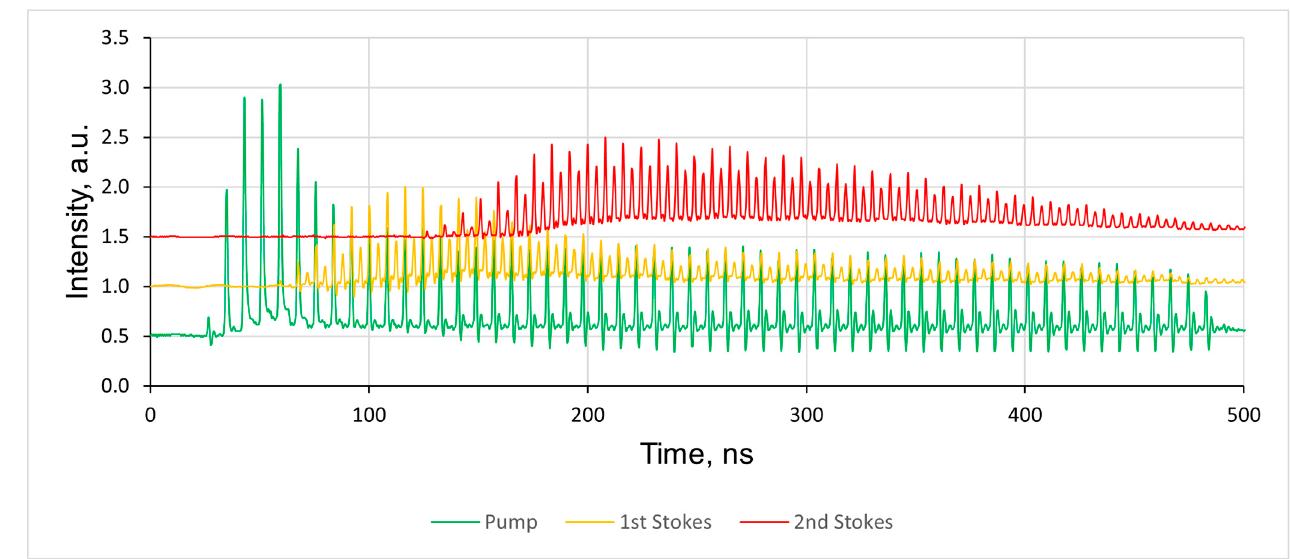
Figure 4. Oscillograms of output radiation components: (green) 1079 nm pump, (yellow) 1198 nm first Stokes, and (red) 1248 nm second Stokes pulse trains.